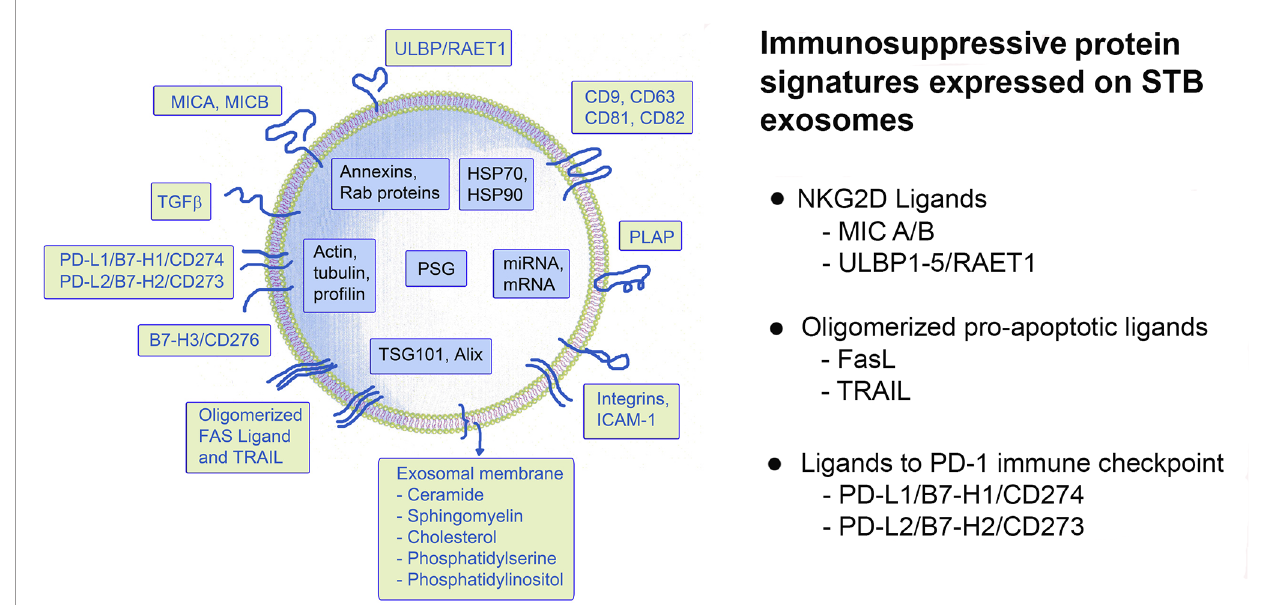
FIGURE 3 | Schematic presentation of a putative STB-derived exosome and a summary of the immunosuppressive signatures, discussed in this